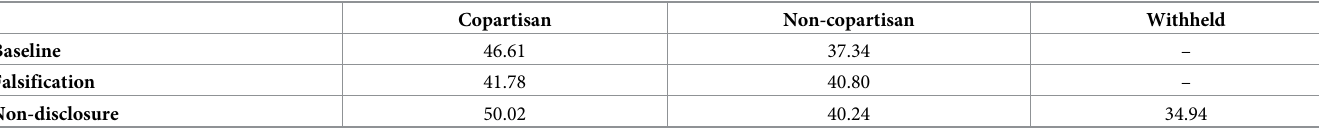
Table 2. Share of equitable contributions by the identity signaled by partners, across experimental